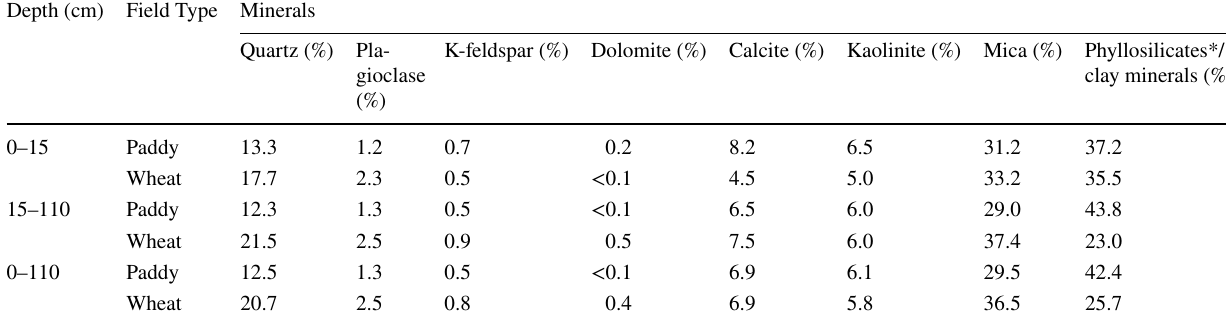
*includes other minerals below detection Table 2). In contrast, average concentration of clay minerals in wheat profile was only 25.7%, which is significantly lower (i.e. ≈ 1.5 times) than that in the paddy profile. However, it is interesting to note that the upper soil horizons (0–15 cm) of both agriculture field show comparable concentration of clay minerals (37.2% and 35.5% for paddy and wheat soils, respectively) which vary widely in the lower soil horizon (43.8% and 23% for paddy and wheat soils, respectively). In entire soil profiles (0–110 cm) clay mineral are quite high in paddy soils (42.4%) than the wheat soils (25.7%). The average concentration of quartz in wheat profile was ≈ 1.5